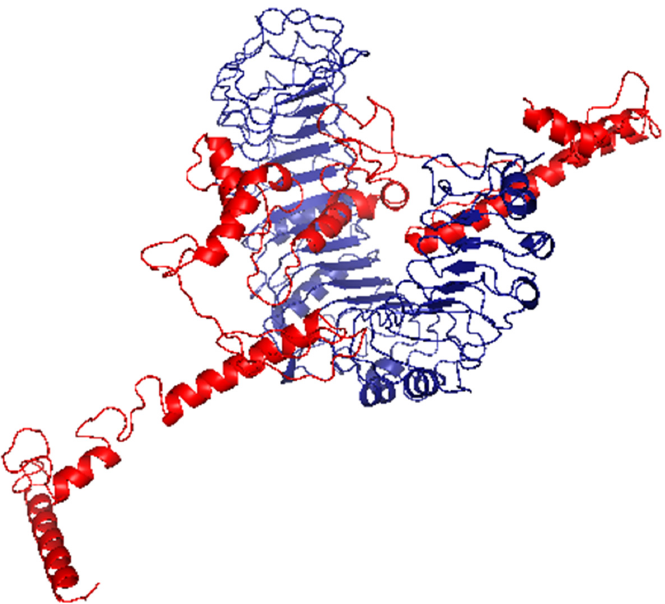
Figure 7. The generated complex of the vaccine ligand (red color) and TLR2 receptor (blue color).